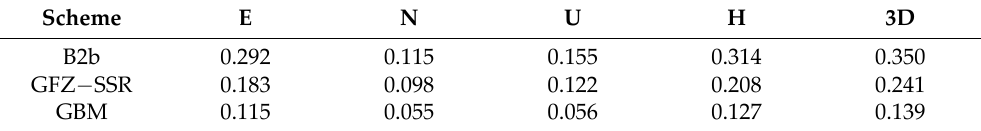
Table 4. RMS statistics of positioning error for the three precise products using tactical IMU (unit: m).